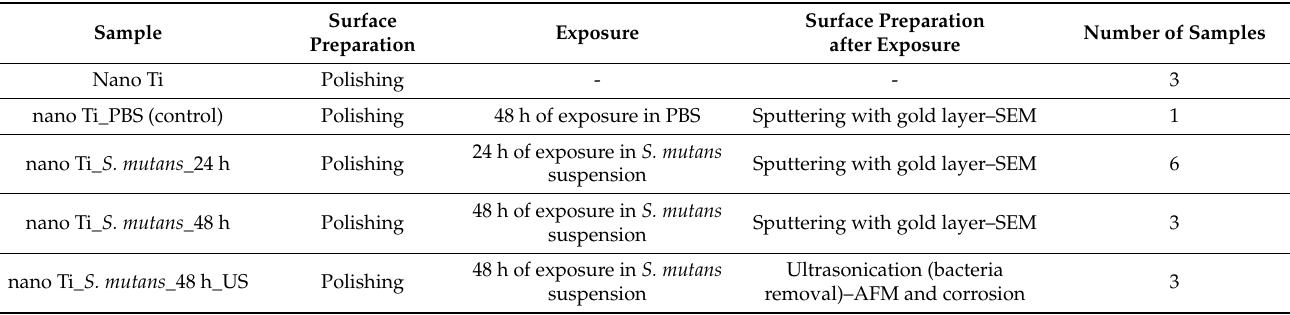
4 of 12 Table 1. Description of tested samples. Sample